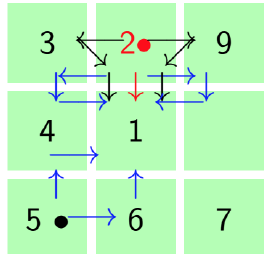
Figure 11. square tiling in small complex two depict the movement of the particle from state j > 1 to state 1 in three